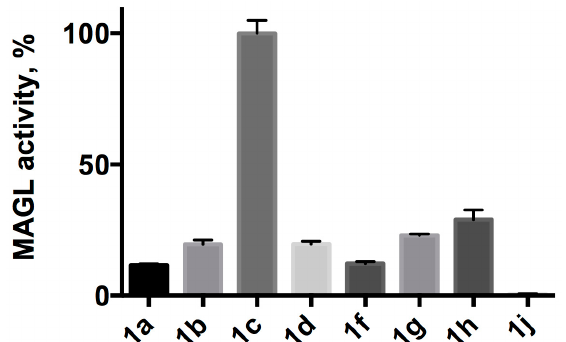
Figure 6. Normalized hydrolysis of different substrates by h MAGL. Release of 7-hydroxyresorufin upon hydrolysis of different resorufynil esters (each at a concentration of 5 μ M) by 25 ng h MAGL was measured in triplicates, the slopes of the regression lines were averaged and then normalized against the slope of the most efficiently hydrolyzed compound. The error bars represent the standard deviation of the results. The following compounds were used as drawn below the bars: acetate ( 1a ), butyrate ( 1b ), octanoate ( 1c ), dodecanoate ( 1d ), oleate ( 1f ), arachidonate ( 1g ), 2-methylhexanoate ( 1h ), and 2-butyloctanoate ( 1j ). The specific activity of the h MAGL preparation was 241.9 U/mg.